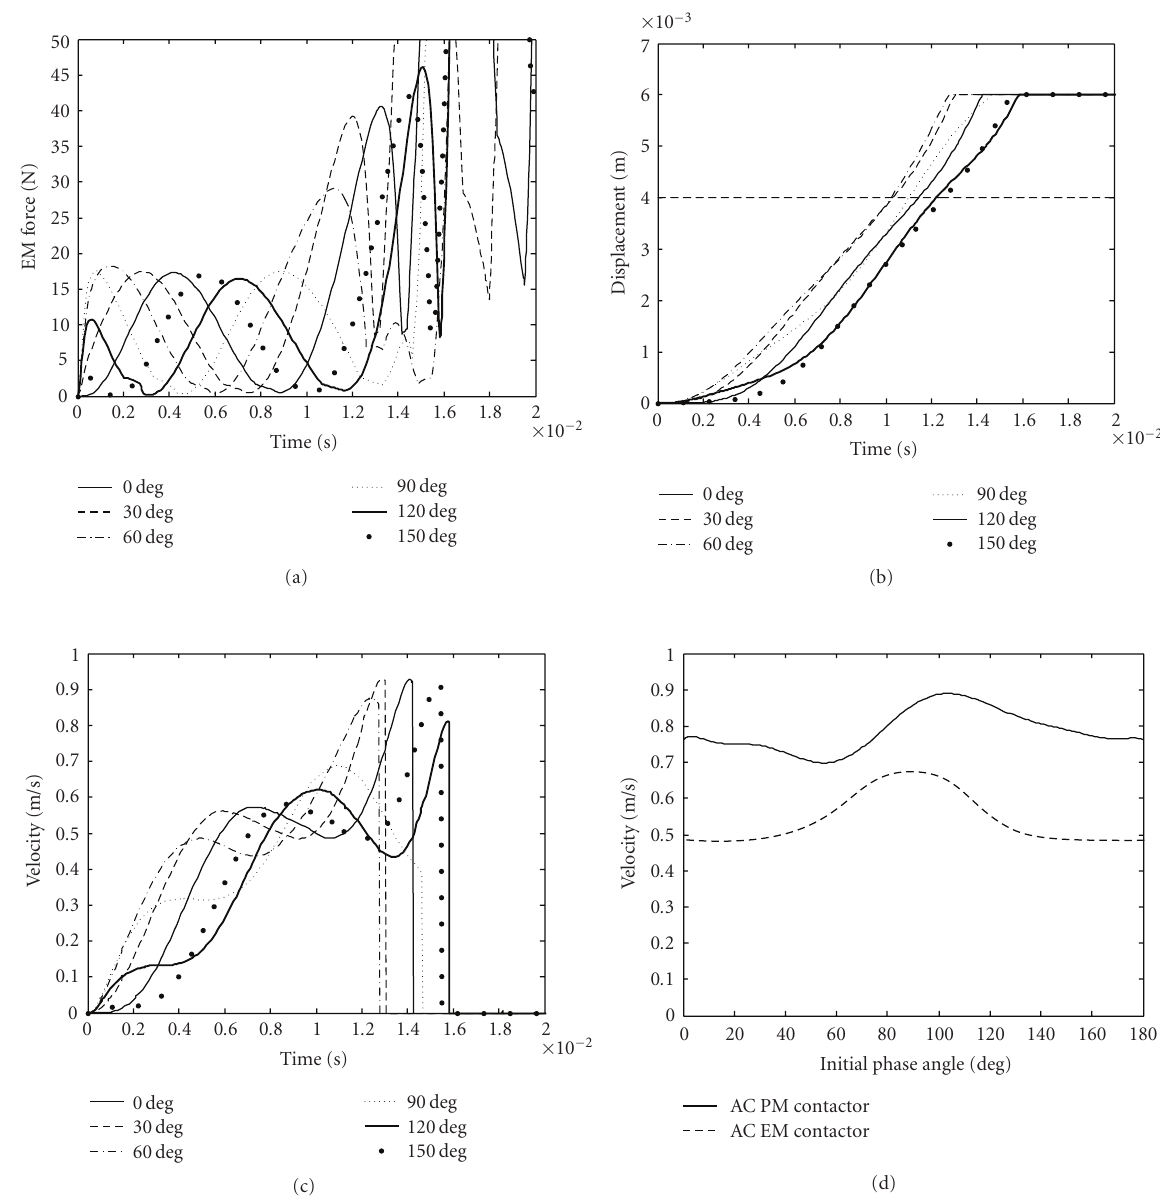
Figure 10: Time-varying curves of (a) magnetic force, (b) armature displacement, (c) armature velocity, and (d) the angle-varying curve of moving